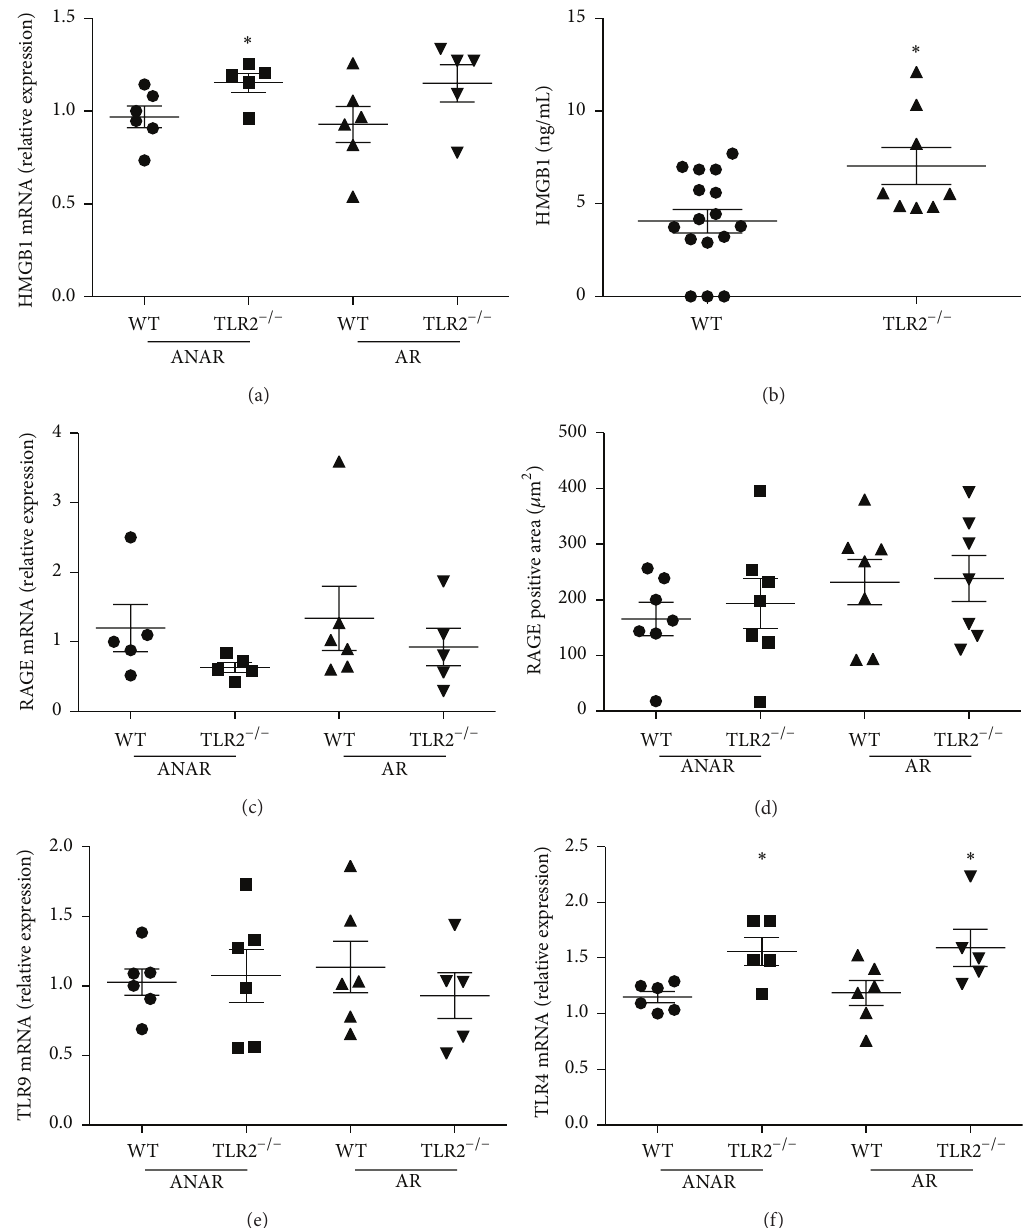
Figure 3: Expression levels of HMGB1 and its receptors after MI/R (30 min/24hrs). (a) A moderate up-regulation of HMGB1 mRNA can be detected in the area not at risk (ANAR) of TLR2 −/− animals, (b) accompanied by increased HMGB1 plasma levels. Expression levels of RAGE (c, d) or TLR9 (e) were not significantly different between genotypes while TLR2 −/− animals showed an up-regulation of TLR4 mRNA (f) compared to WT in ANAR and AR. ∗ 𝑃 < 0.05 , ANAR area not at risk, AR area at